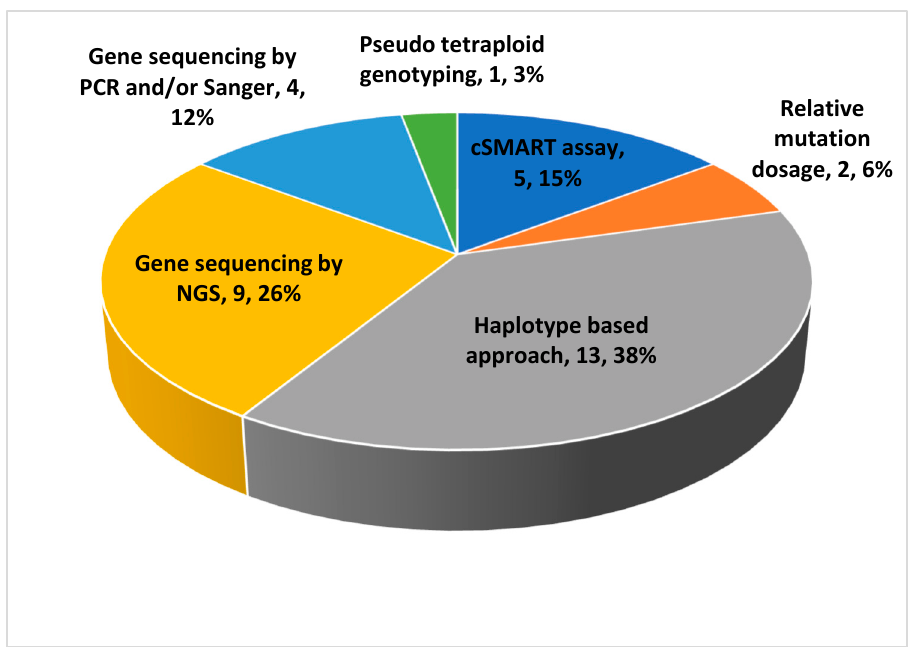
Figure 2. Subdivision of the studies based on the analytical methods used.